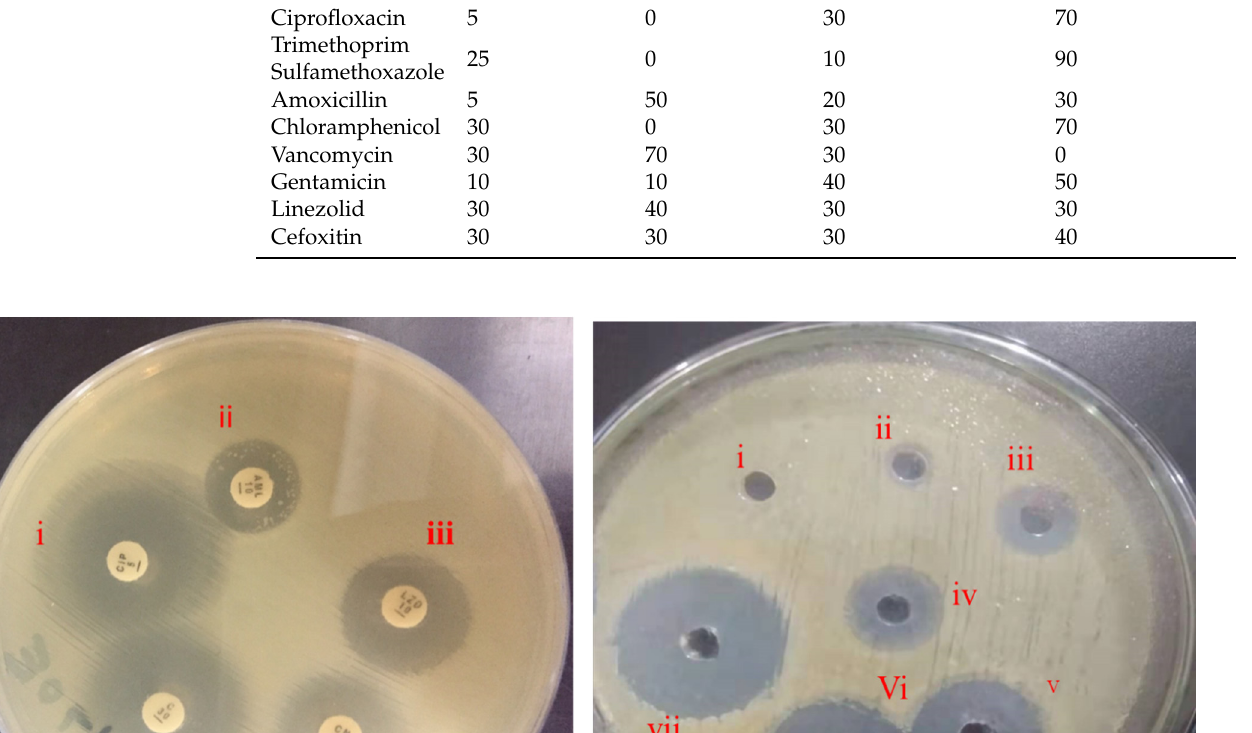
Table 4. Comparison of zones of inhibitions (mm) of E. coli isolates against different combinations of antibiotics/drugs.